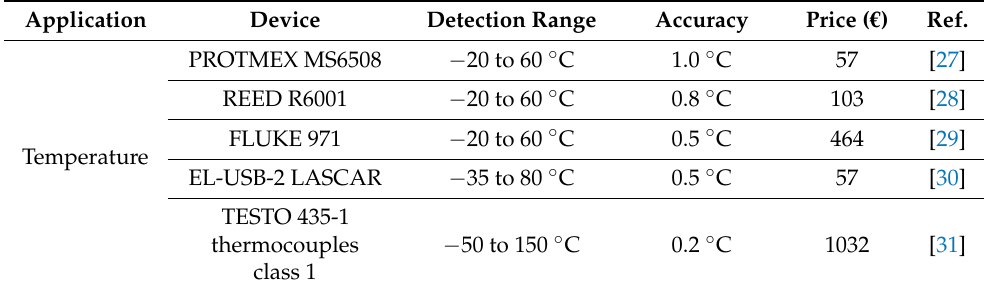
Table 1. List of commercial systems in the market for indoor monitoring of